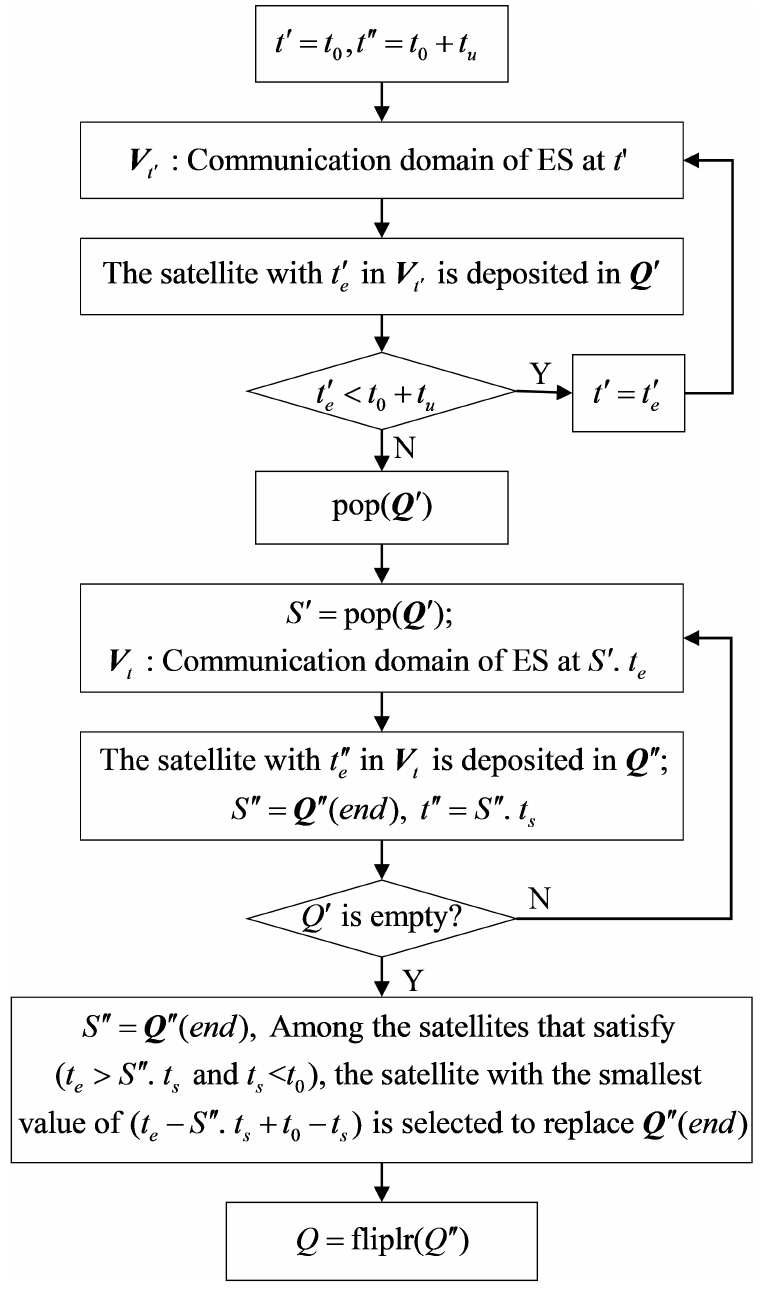
Figure 5. Flow chart of the algorithm to calculate the Q